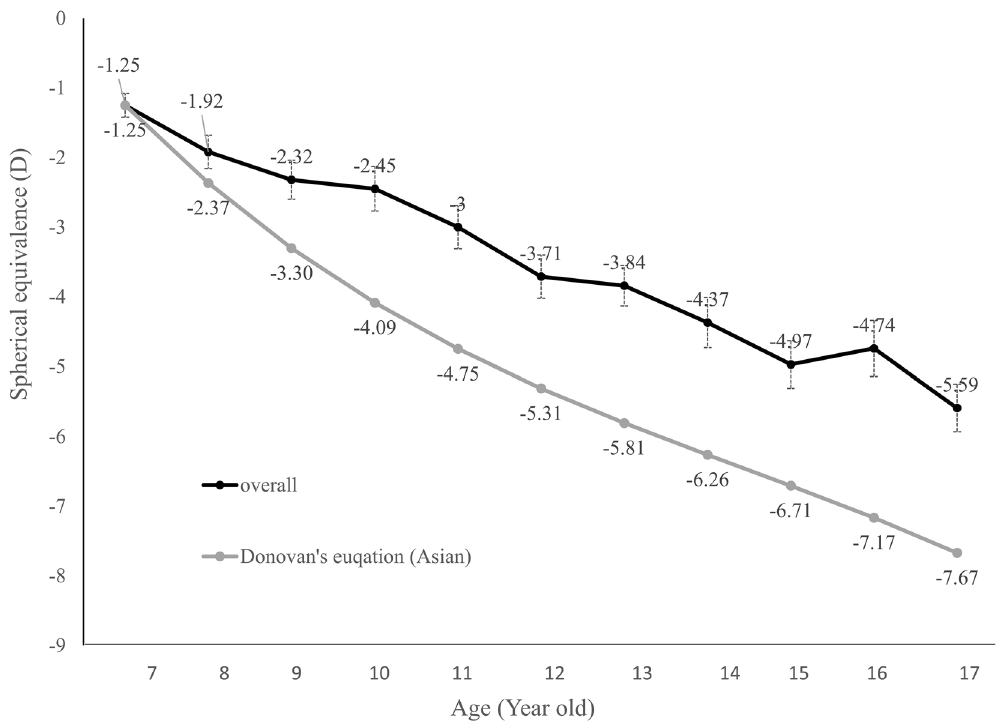
Figure 5. Spherical equivalence status in the patients with atropine treatment in our study and the estimated controls by predicted equation for 10 years. D, diopter. Bars, standard error of the